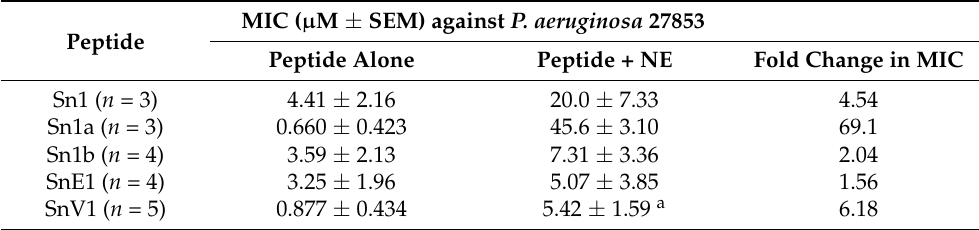
Table 2. Mean ( ± SEM) MIC values against P. aeruginosa 27853. Peptides were incubated with/without NE for four hours prior to RDA. Mann–Whitney, peptide alone vs. peptide + NE. a p = 0.0317. MIC ( µ M ± SEM) against P. aeruginosa 27853 Peptide Peptide Alone Peptide +